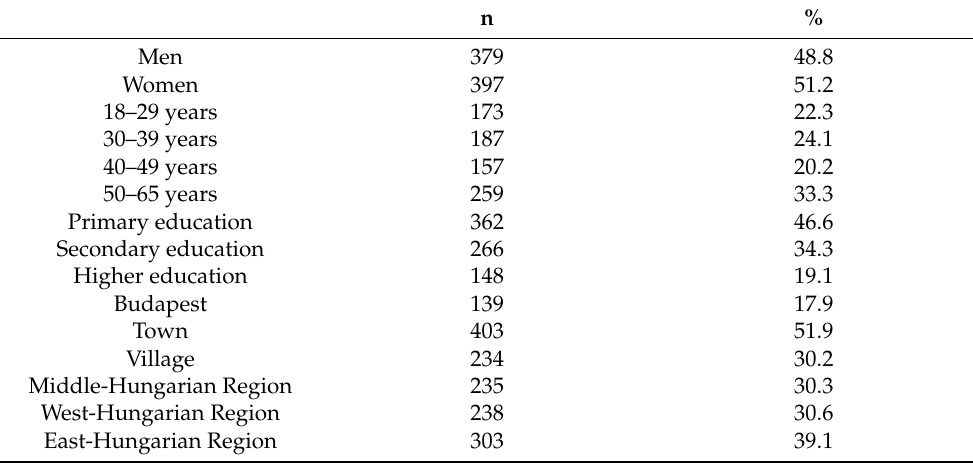
Table 1. Description of the